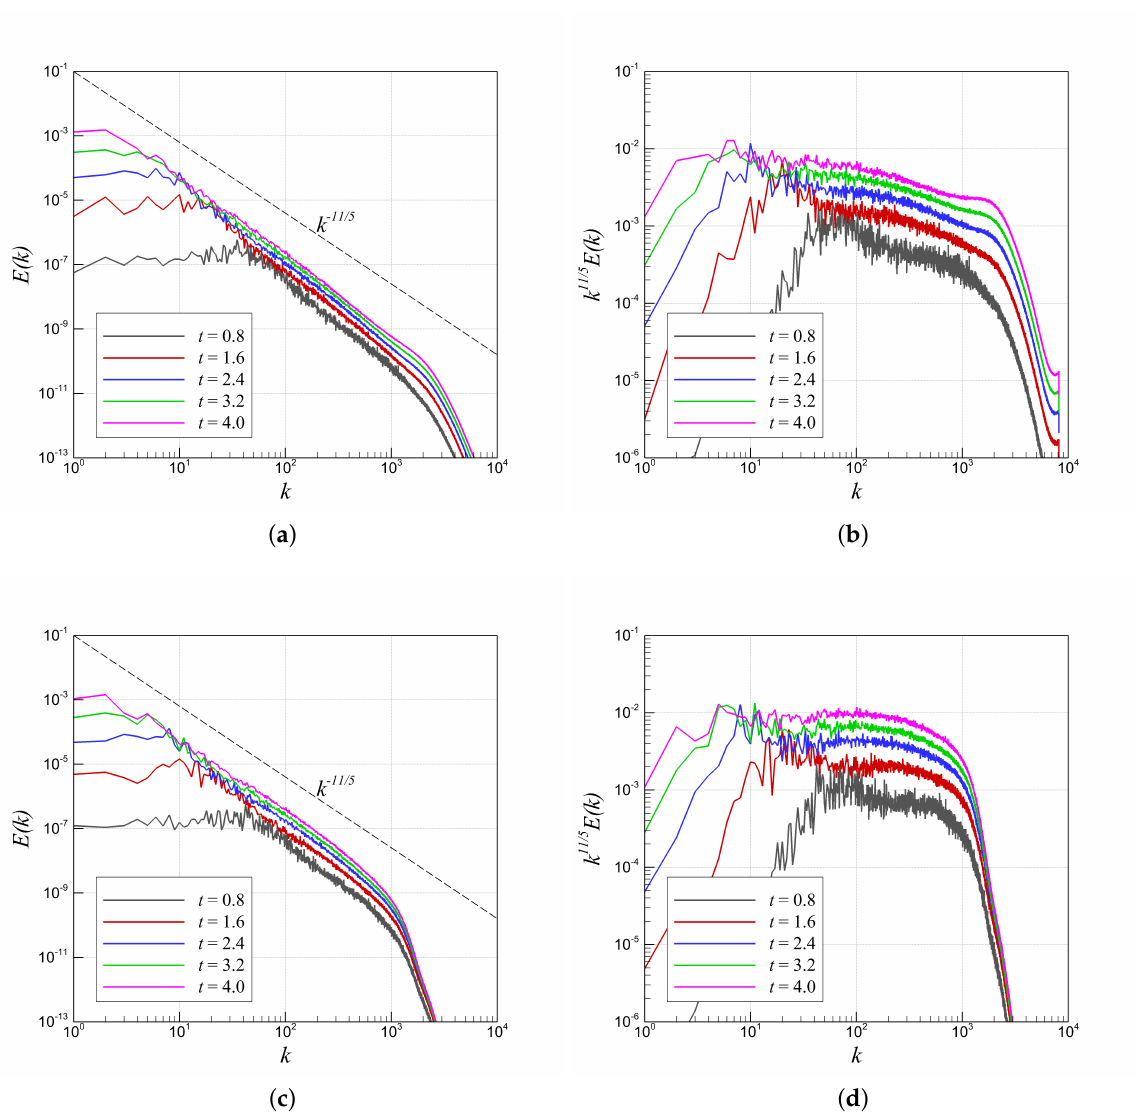
Figure 7. Time evolution of kinetic energy spectra and compensated kinetic energy spectra for the RTI problem with multi-mode perturbation obtained using different modeling approaches at a resolution of 16384 × 24576; ( a ) kinetic energy spectra using ILES-Roe solver; ( b ) compensated kinetic energy spectra using ILES-Roe solver; ( c ) kinetic energy spectra using CS+RF ( σ = 1.0) solver; ( d ) compensated kinetic energy spectra using CS+RF ( σ = 1.0)